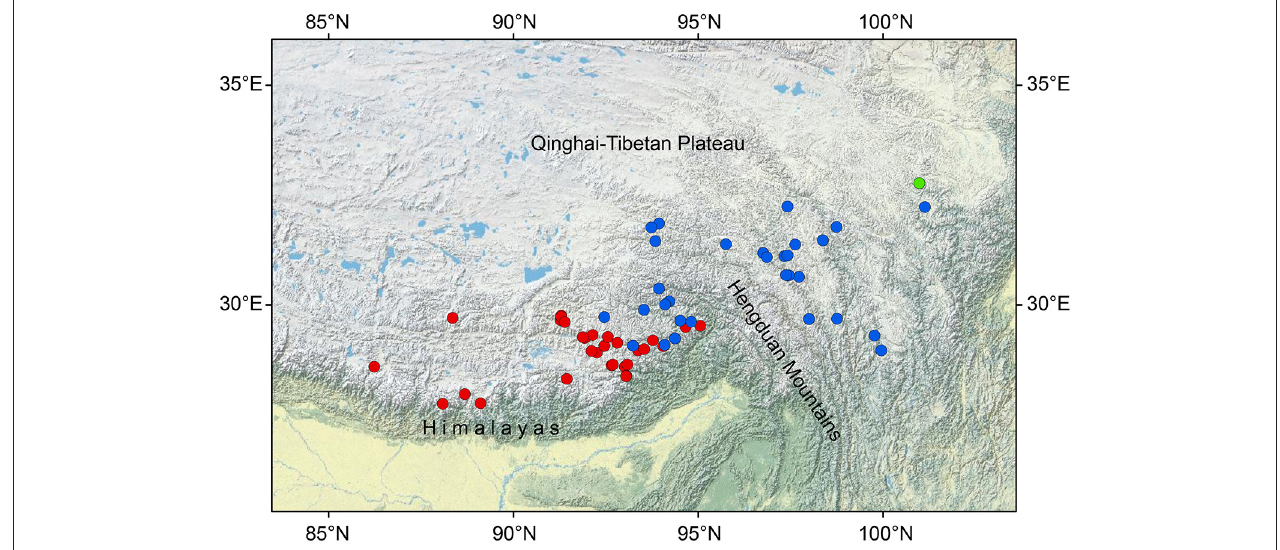
FIGURE 1 | Geographical distribution of Saxifraga umbellulata (red spots), S. pasumensis (blue spots) and S. banmaensis (green spot). Data are based on specimens studied by us in BM, HNWP, KUN, and